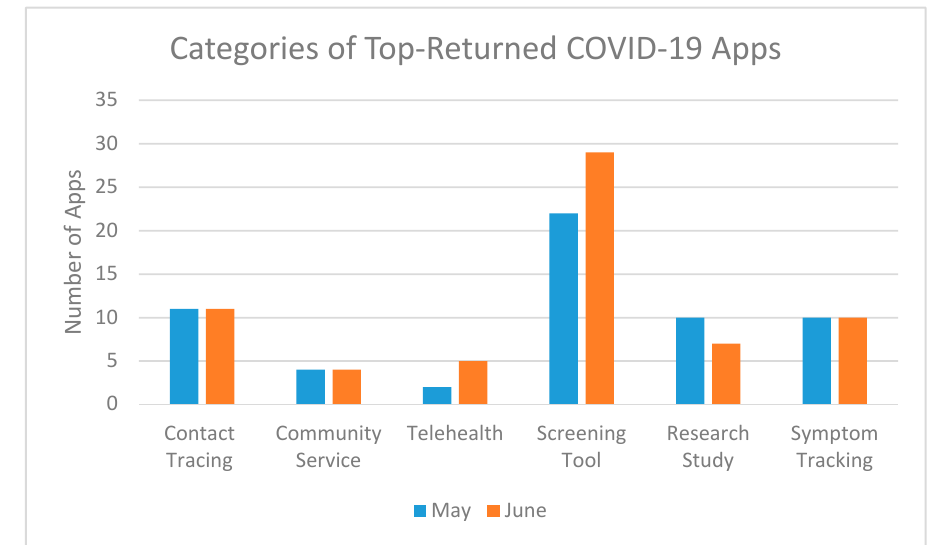
Figure 2. Categories of Top-Returned COVID-19 Apps. Screening tools were the most common type of app returned in both May and June.